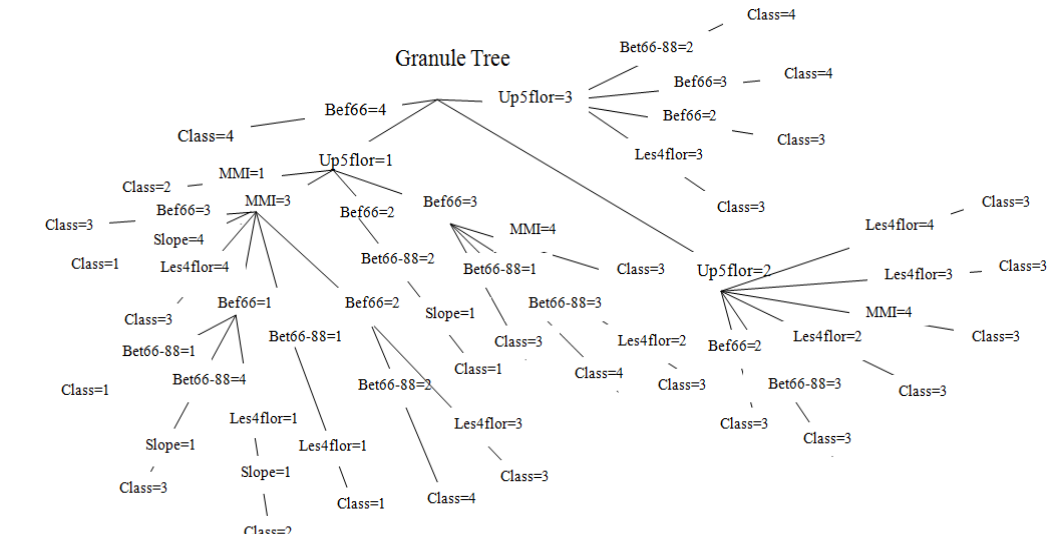
Figure 2. Granular tree based GrC model using neighbourhood systems concept